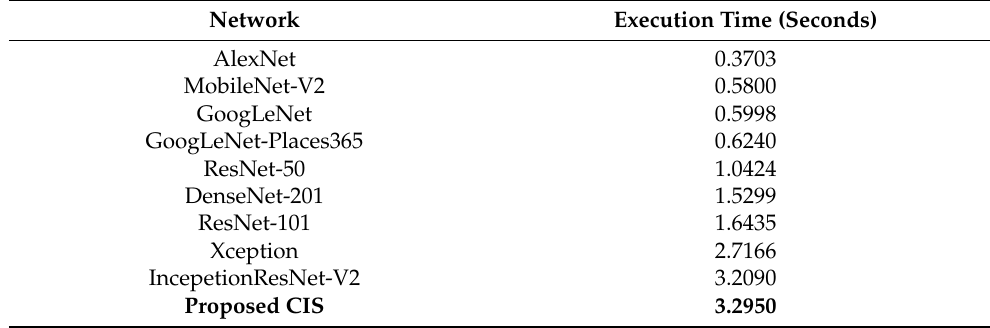
Table 6. The proposed system with collective decision execution times for 30 randomly selected images in order of the increasing